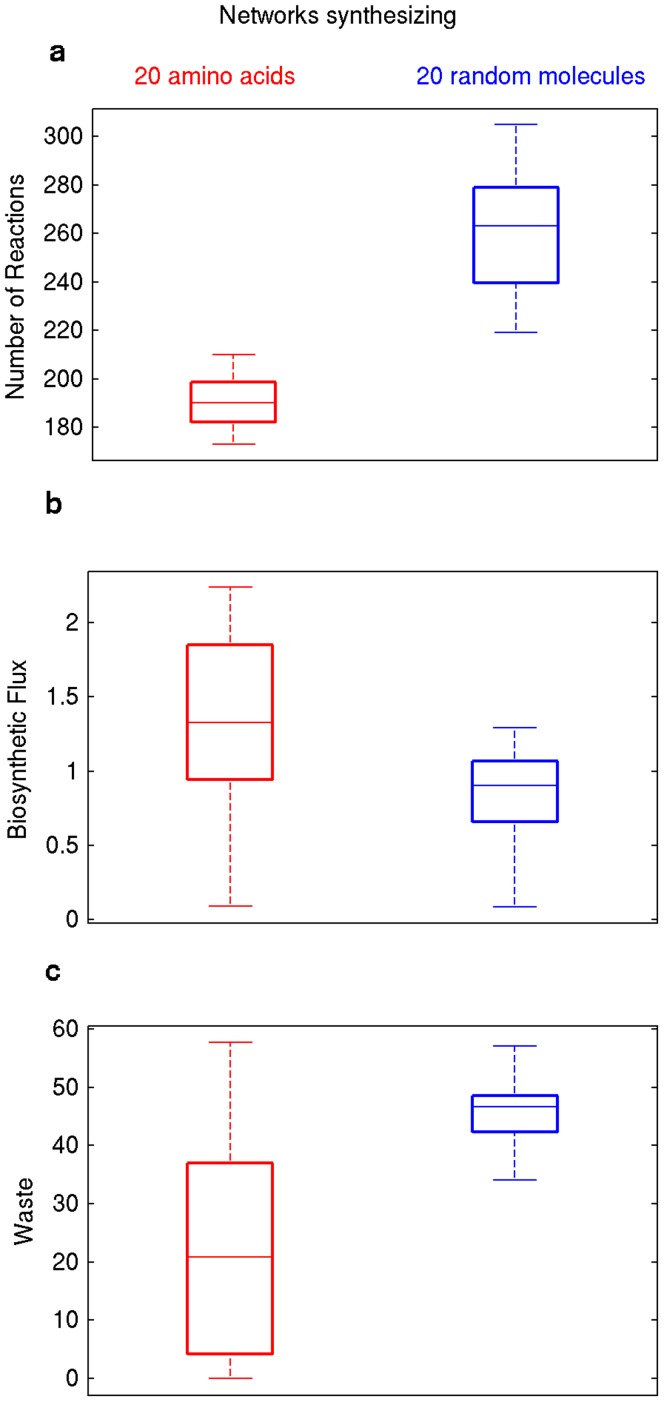
Synthesis of biochemically related compounds require less reactions, achieve higher biosynthetic flux with less waste.Box-plot of a) number of reactions, b) biosynthetic flux in mmoles per g DW hour, and c) waste in mmoles per g DW per hour in minimal networks synthesizing twenty amino acids (left panel) and synthesizing twenty random biomass molecules (right panel). Horizontal lines in the middle of each box mark the median. The edges of the boxes correspond to the 25th and 75th percentiles. Data is based on a sample of n = 80 for each box.